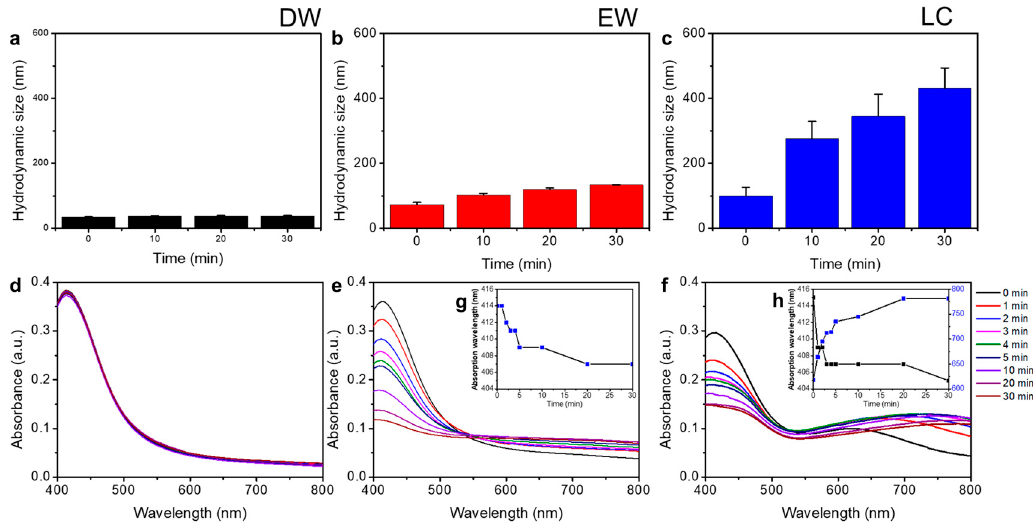
Figure 3. Physicochemical properties of AgNPs ‐ Cit. ( a – c ) Hydrodynamic diameter and ( d – f ) absorbance of AgNPs ‐ Cit were measured in distilled water (DW), E3 egg water (EW), and low chloride (LC) medium by time (0~30 min). AgNPs ‐ Cit were dispersed at same concentration (5 μ g/mL) in each medium. The inset graph of ( g , h ) indicate shifts of AgNPs ‐ Cit absorbance in different media (DW, EW, and LC) with elapsed time (0~30 min).